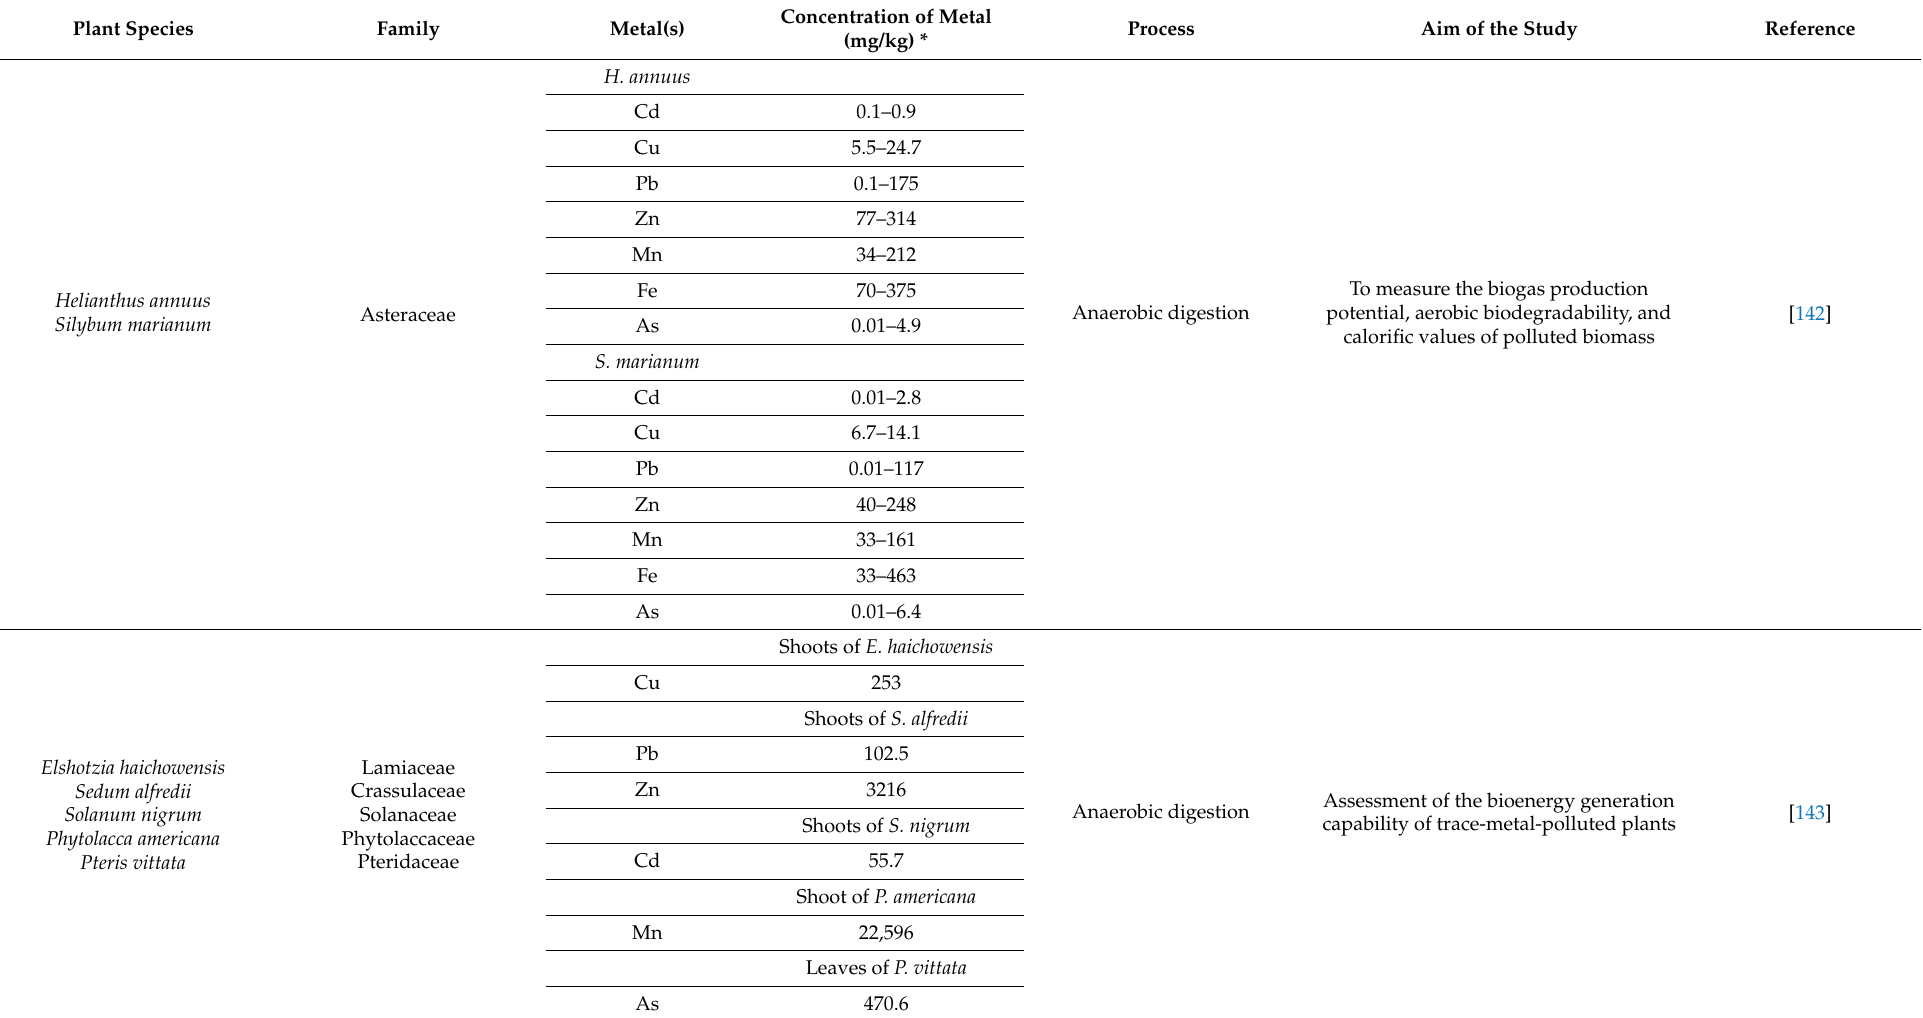
Table 5. Biochemical conversion of phytoremediation biomass to produce